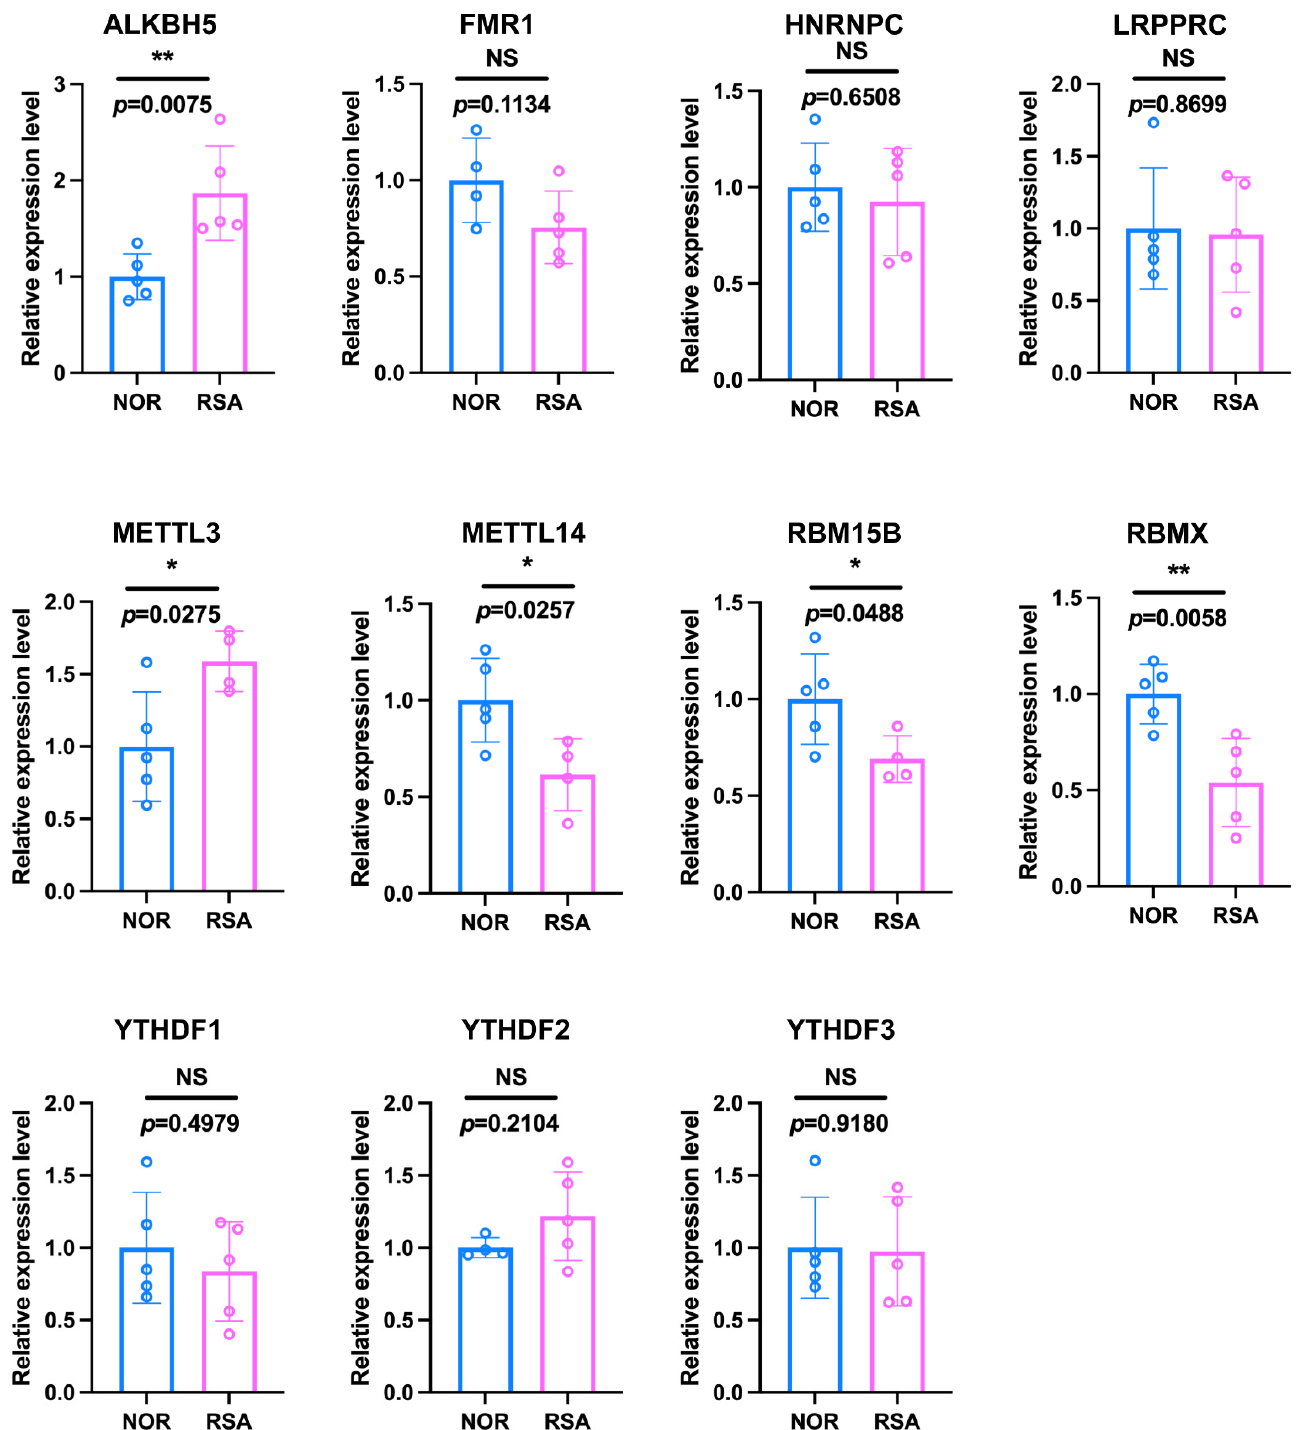
Figure 5. mRNA expression levels of significant m6A regulators in primary human ESCs. *: p < 0.05, **: p < 0.01, NS: Non ‐ significance.